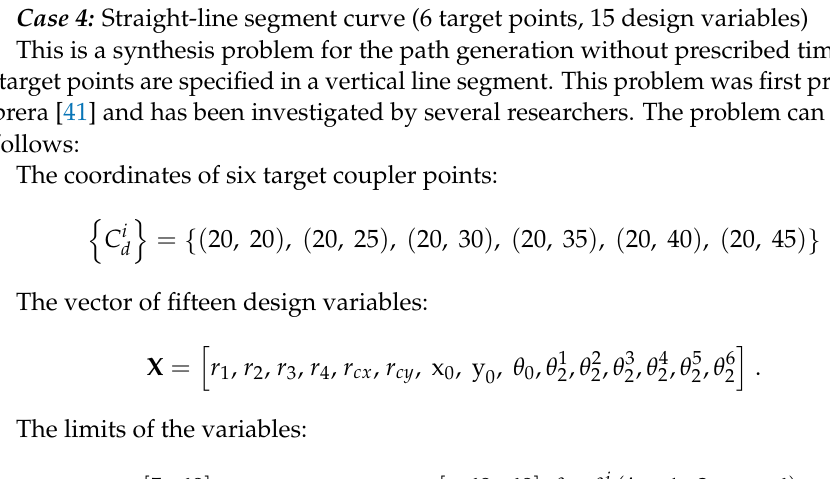
2000. The convergence rates of the five metaheuristic methods are shown in Figure 19, the convergence rate of L-EPSDE was faster than those of HPSO and EPSDE, which converged to an optimal solution of more than 1500 iterations, but slightly slower than those of DE-gr and PSO, which converged to optimal solution less than 100